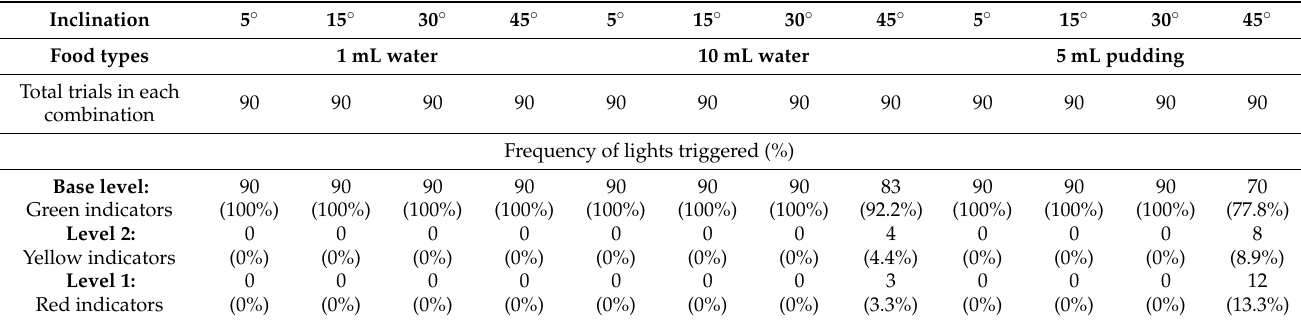
Table 5. Signals triggered within different combinations of inclination angles and food types. (Num- ber of participants = 30; repetitions for each combination =